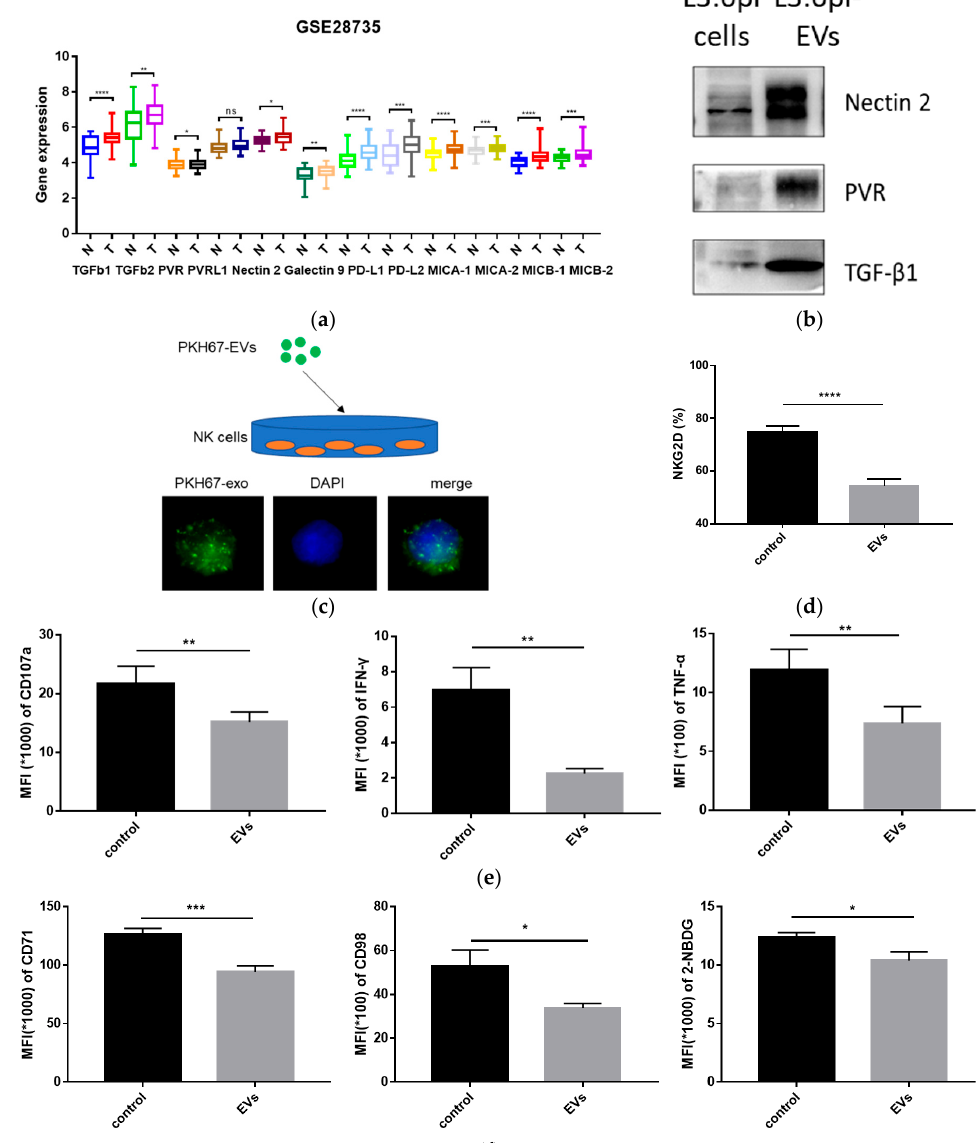
Figure 4. Pancreatic cancer-derived EVs impair natural kill (NK) cell function. ( a ) Relative mRNA expression of representative immune regulatory factors in tumor tissues (T) and non-tumor tissues (N) in pancreatic cancer from the GSE28735 dataset, n = 45. ( b ) The expression of nectin-2, PVR, and TGF- β 1 was determined by Western blotting in L3.6pl-derived EVs and L3.6pl cells. ( c ) Analysis of pancreatic cancer-derived EVs’ uptake by NK cells using confocal microscopy. L3.6pl-derived EVs were stained with PKH67 (green) and incubated with NK cells for 24 h. The nucleus was labeled with DAPI (blue). ( d ) NK cells were treated with PBS or L3.6pl-derived EVs for 24 h. The percentage of NKG2D-positive NK cells was analyzed by flow cytometry. ( e ) NK cells pre-treated with PBS or L3.6pl-derived EVs were co-cultured with L3.6pl cells at a 1:1 ratio for 5 h. The mean fluorescence intensity (MFI) of CD107a (left), IFN- γ (middle), and TNF- α (right) in NK cells was analyzed by flow cytometry. ( f ) NK cells were treated with PBS or L3.6pl-derived EVs for 24 h. NK cells were then analyzed by flow cytometry to determine the MFI of CD71 (left) and CD98 (middle) and 2-NBDG incorporation (right). Data are the means ± SD of four experiments. ns, no significant difference, * p < 0.05, ** p < 0.01, *** p < 0.001, **** p < 0.0001 by Student’s t